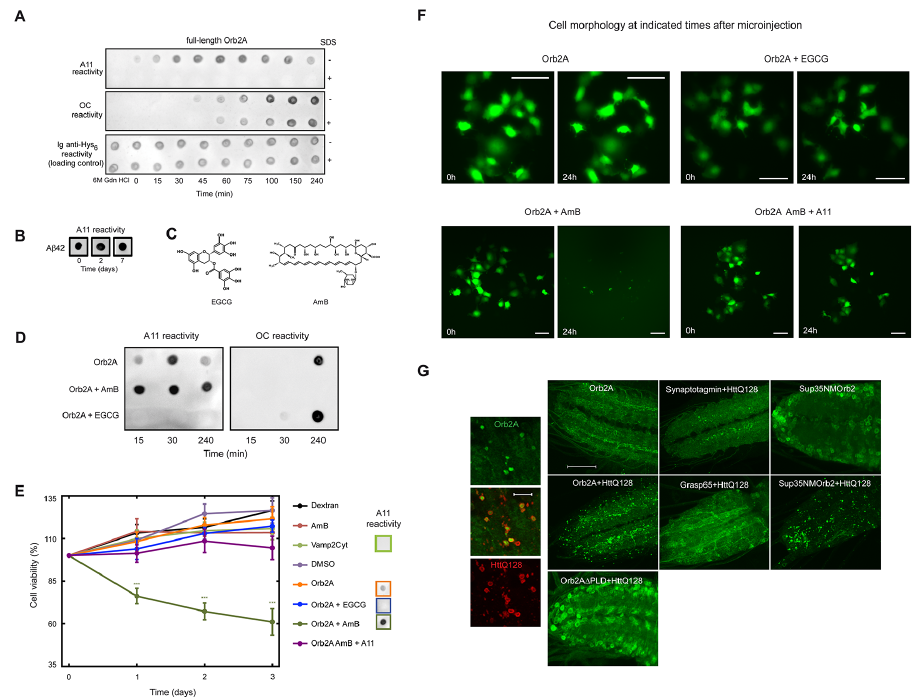
Fig 5. Orb2 cytotoxic oligomeric species rapidly evolve into mature amyloids and they can be kinetically trapped as well as sequestered by pathological amyloids. (A) Structural features during Orb2A assembly probed with conformational antibodies showed the formation of species reactive to A11 and OC antibodies. OC can exist in a SDS-resistant form, while A11-reactive oligomers are SDS-sensitive. (B) Lifespan of A β 42 A11-reactive species. (C) Chemical structure of EGCG (left) and amphotericin B (AmB, right), used to trap OC- and A11-reactive oligomers, respectively. (D) Immunodot blot analysis of Orb2A: EGCG and Orb2A:AmB complexes probed with A11 and OC conformational antibodies show that oligomers trapped in the presence of EGCG interact with the OC antibody (and not with A11), whereas those formed in the presence of AmB react strongly with the A11 antibody (and not with OC antibody). (E) Survival curves of COS-7 cells microinjected with several samples (the A11-reactivity of which is indicated). Data are represented as the mean ± SEM: *** p < 0.001 (green asterisks, Orb2A:AmB versus remaining samples; Two-way ANOVA and Bonferroni post-test). Dextran, AmB, the intrinsically disordered region of Vamp2 (Vamp2Cyt) and dimethylsulfoxide (DMSO) are used as controls. The number of single-cells microinjected per sample was n = 100 – 200. (F) Fluorescence micrographs of COS-7 cells microinjected with different samples and fluorescein-labelled dextran (at 0 and 24 h after microinjection). Microinjection of the Orb2A: AmB complex resulted in a marked drop in the number of live cells at 24 h compared to those at 0 h. Notably, the A11 antibody rescued cells from apoptosis. Scale bars: 100 μ m. (G) Huntingtin protein-containing expanded polyQ repeats (HttQ128) enhances Orb2A aggregation, and this enhancement requires the Orb2A PLD. Orb2A and HttQ128 coaggregates. HttQ does not induce aggregation of other EGFP-tagged neuronal proteins. Substitution of Orb2A PLD with the NM region of yeast Sup35 showed similar HttQ-dependent aggregation. Scale bar: large panel 20 μ m, inset 10 μ m. The underlying data for panels in this figure can be found in S1